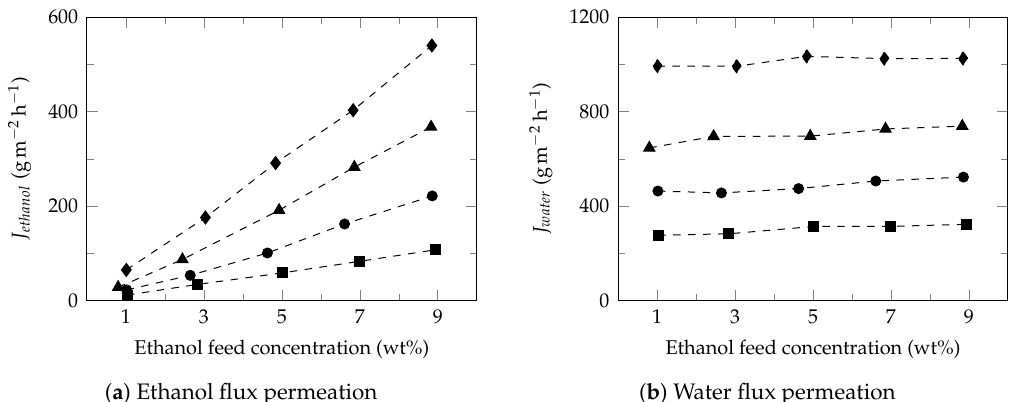
Figure 4. Effect of ethanol feed concentration on the ethanol and water fluxes. Feed temperature: 34°C ( (cid:4) ), 40°C ( ( (cid:78) ) and 50°C ( (cid:7) ).